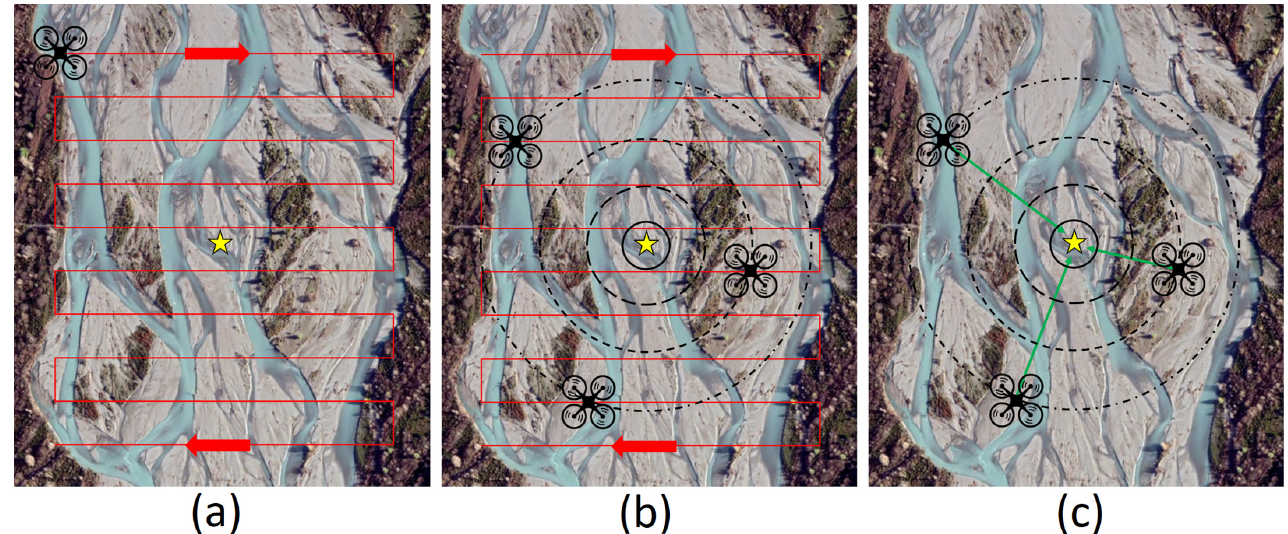
Figure 6. ( a ) Zigzag flight path of UAV with relay unit over the river to locate the deployed stone and Kinematic Logger (yellow star), ( b ) the UAV receives LoRa messages from the Kinematic Logger at multiple locations along the flight path, ( c ) the location of the Kinematic Logger is estimated from received signal strength and triangulation principles.